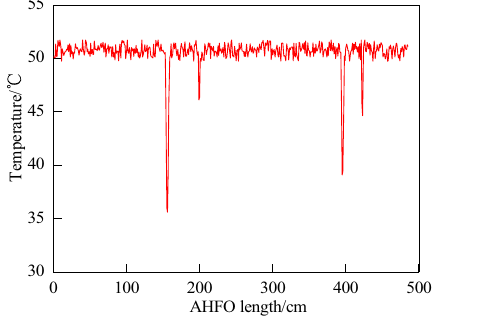
Figure 7. AHFO monitoring